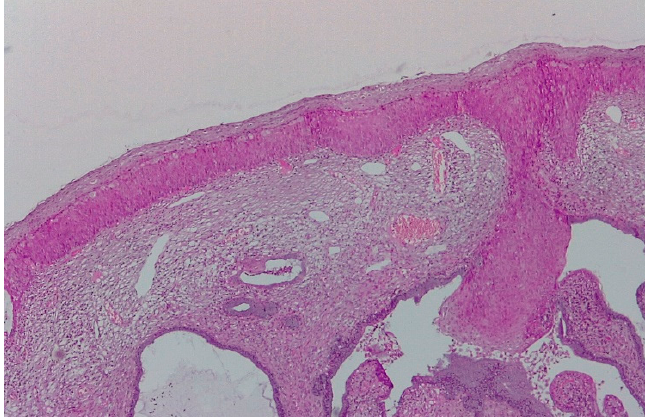
Figure 7. Histological correspondence of the case above, CIN2 lesion: image containing squamous papillary epithelium with many koilocytes and intraglandular mature metaplasia (hematoxylin– eosin 5×).